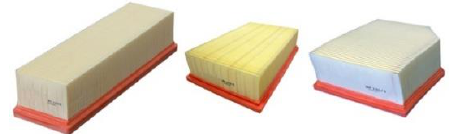
Fig. 5. Types of air filter elements: a) paper filter element, b) non-woven filter inserts Basic criterion for selecting an active filtering